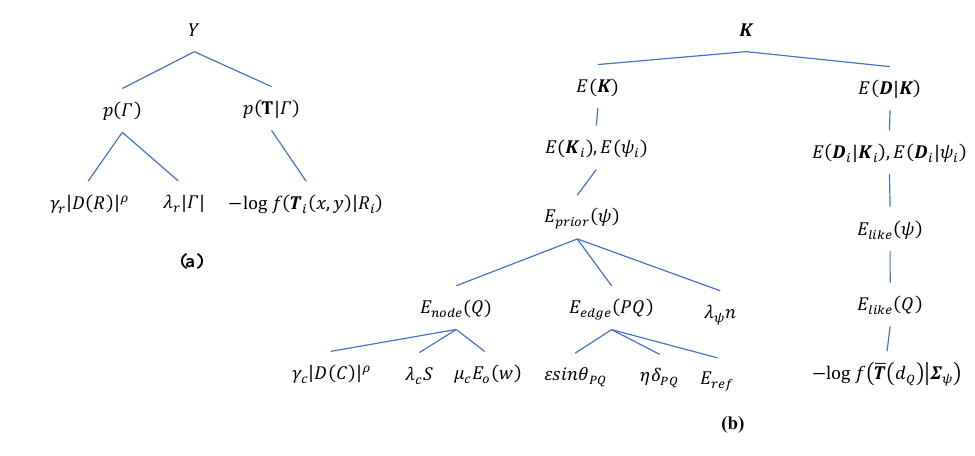
Figure A1. Diagram of the symbols in the model of water network construction: ( a ) diagram of water branch extraction; ( b ) diagram of water branch